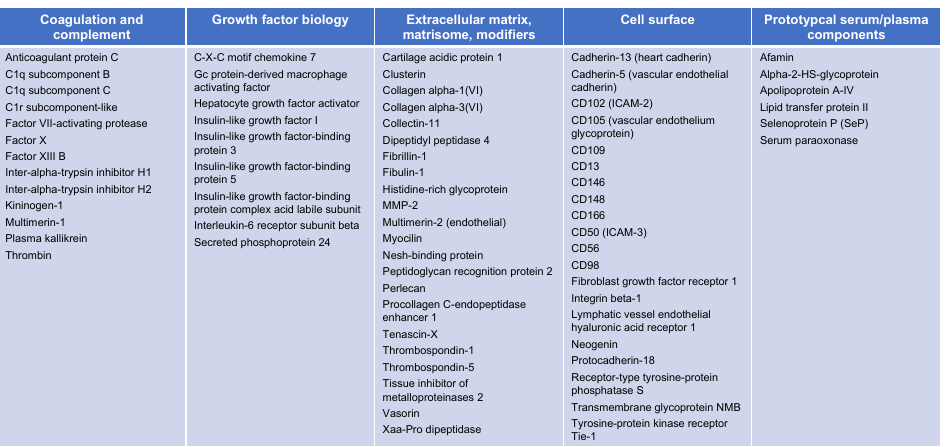
Figure 4. Clust analysis [18] to identify protein groups whose abundance negatively or positively correlated with disease severity together with partial reversal to healthy levels upon surgical treat ‐ ment of aortic dissections. The clust algorithm determined quantile and z ‐ score normalization as optimal.